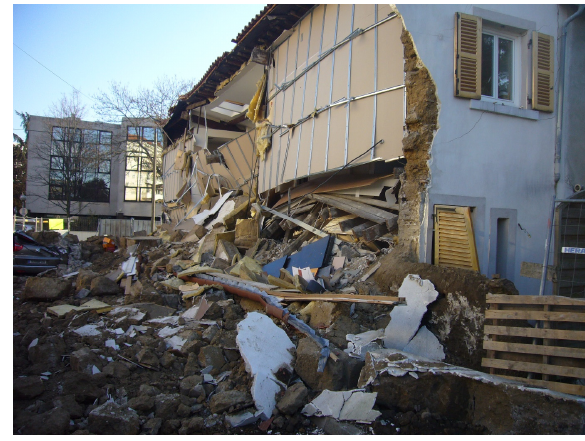
Figure 3. Structural collapse due to inappropriate refurbishment (cement bases, plaster, Rockwool insulation and gypsum board, among others) of a vernacular rammed earth house subjected to water accumulation at the wall base, Lyon, France.